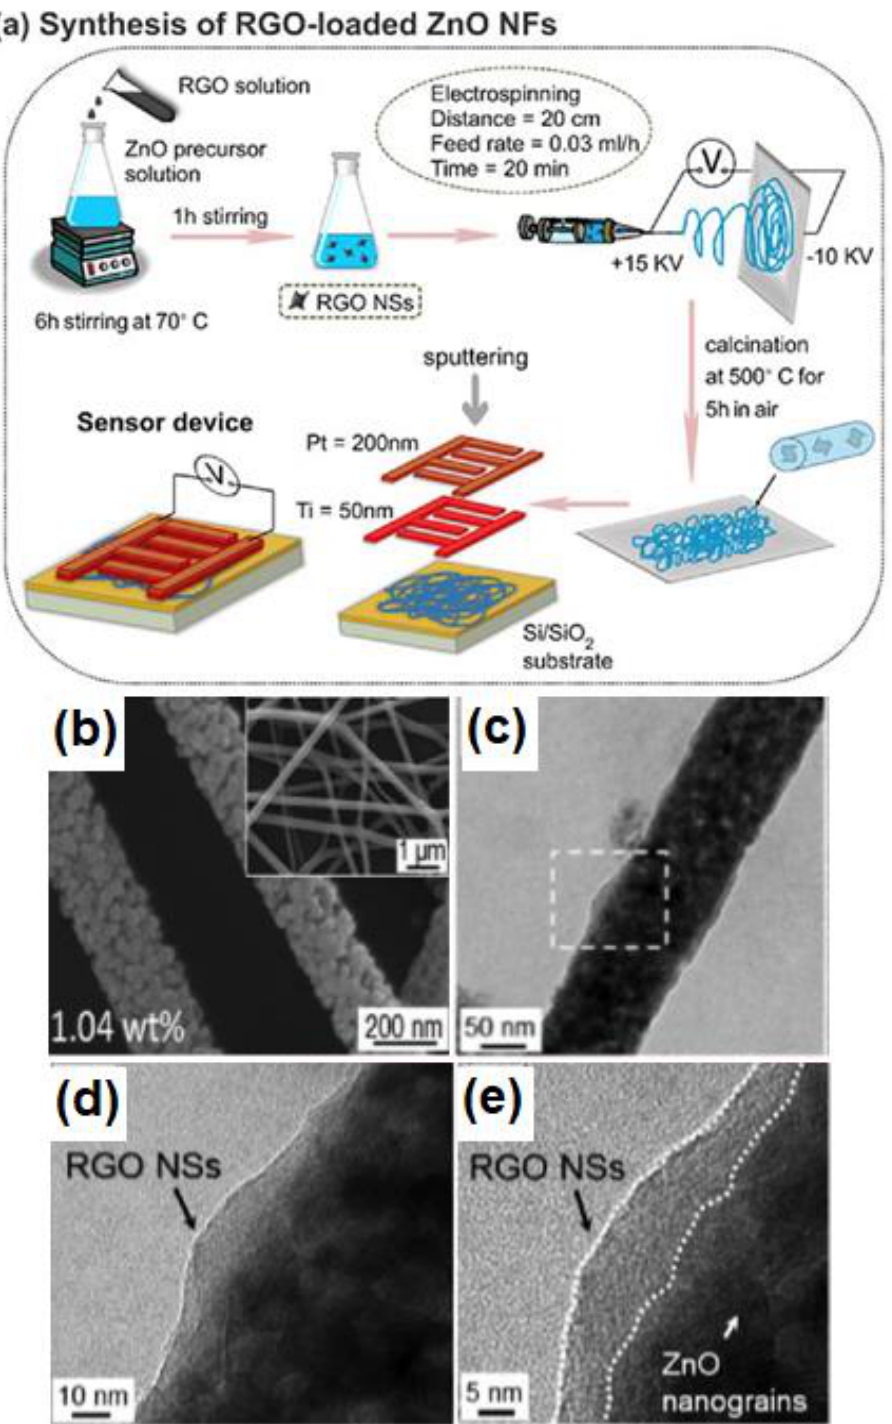
Figure 3b–d. A similar strategy has also been used to conjugate rGO with SnO 2 , In 2 O 3 , Fe 2 O 3 and so on [62–64].